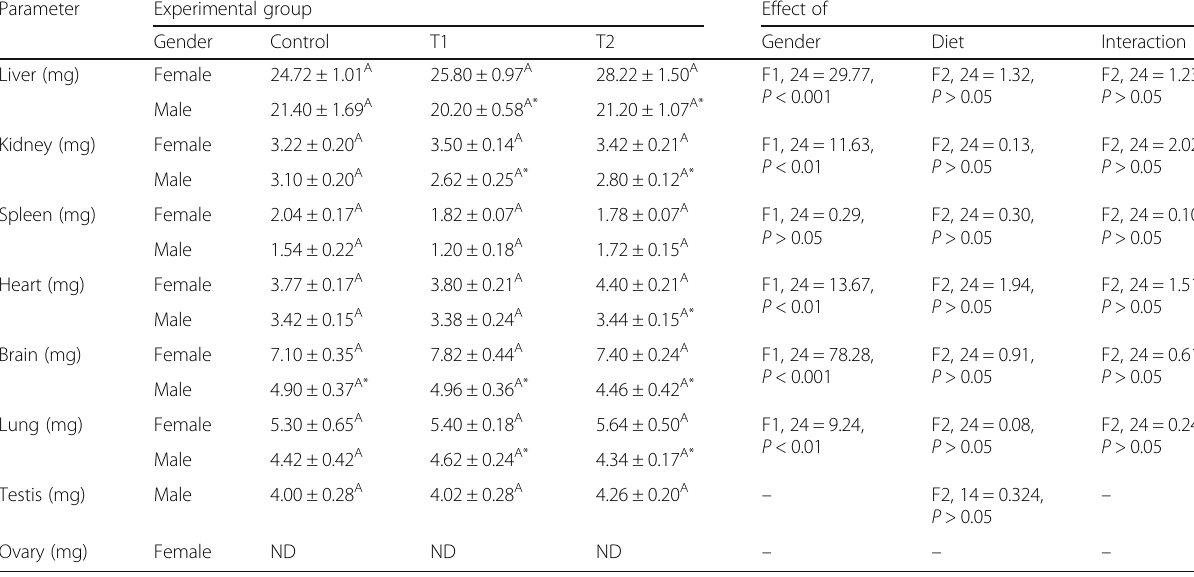
* Represent significant differences ( P <0.05) in comparison to the corresponding female groups. In each row, the mean values marked with the same superscript letter are similar (insignificant, P >0.05), whereas those with different ones are significantly differed ( P <0.05). P >0.05: insignificant, P <0.05, P <0.01 and P <0.001: significant effect at α =0.05, 0.01 and 0.001, respectively. ND not